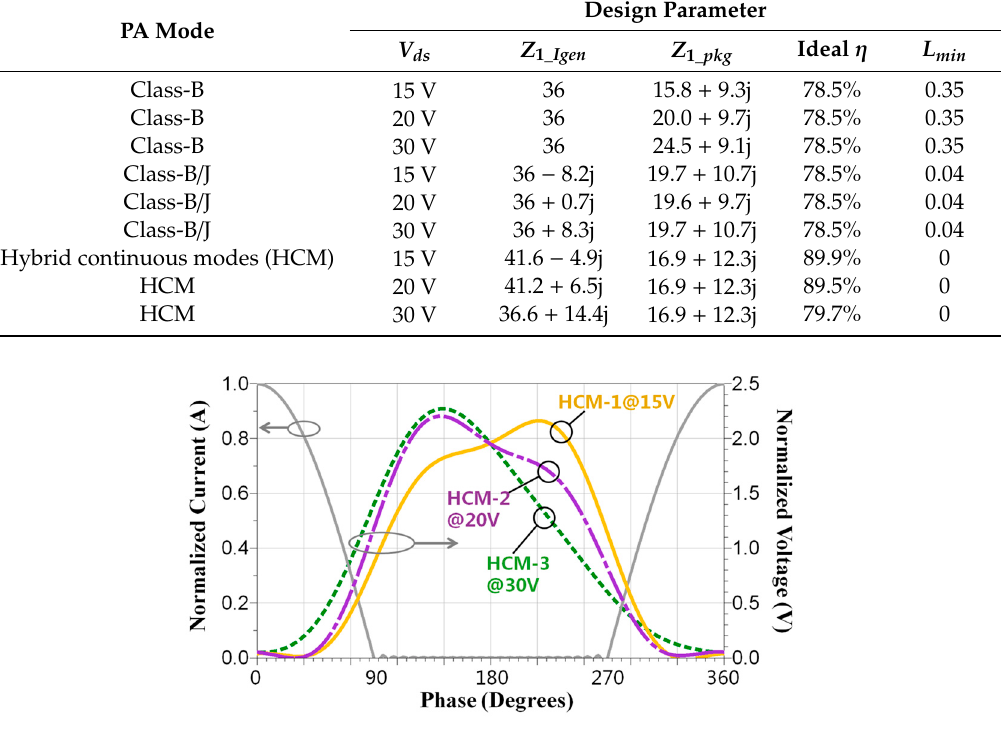
Figure 4. Normalized drain voltage and current waveforms of HCM PAs.